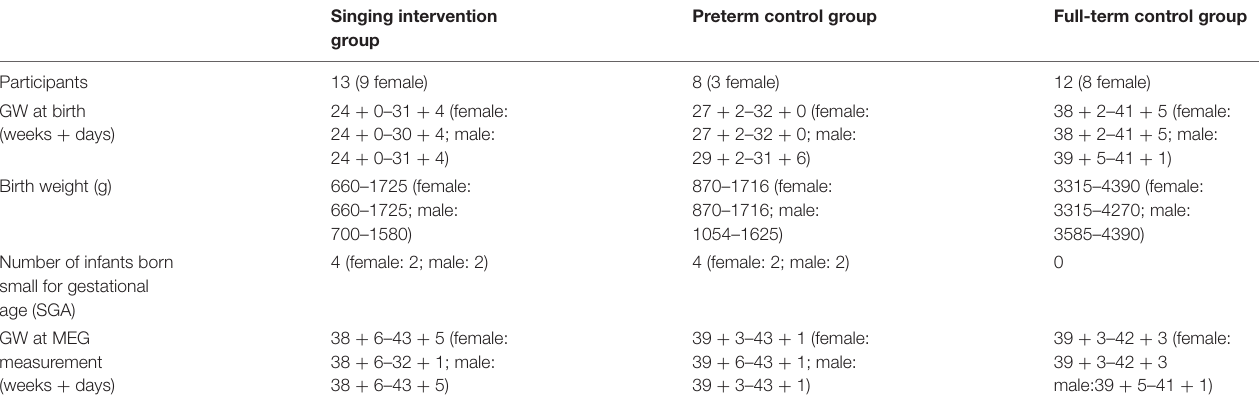
TABLE 1 | Background information for the preterm infants participating in the experiment. Singing intervention